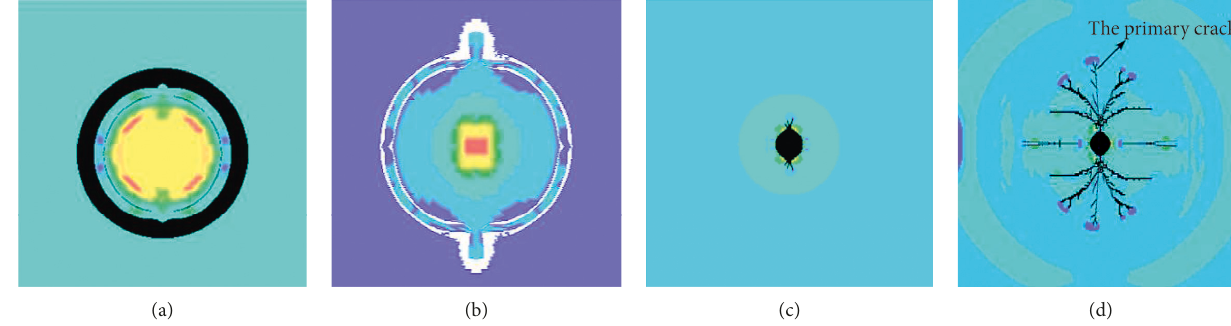
Figure 3: The initiation and propagation of the directional crack in the mudstone: (a) t � 1.89; (b) t � 6; (c) t � 60; (d) t �